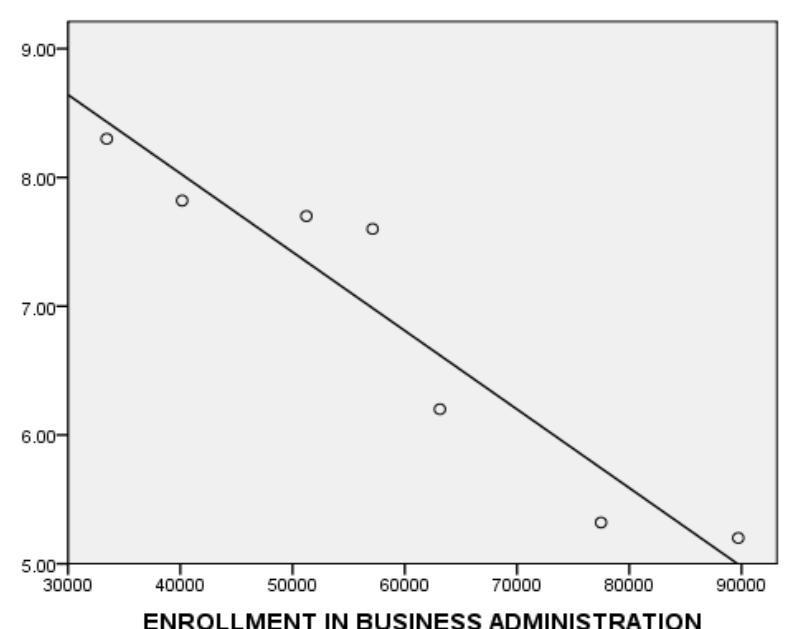
Figure 4: Curve Estimation of the Unemployment rate and Entrepreneurship